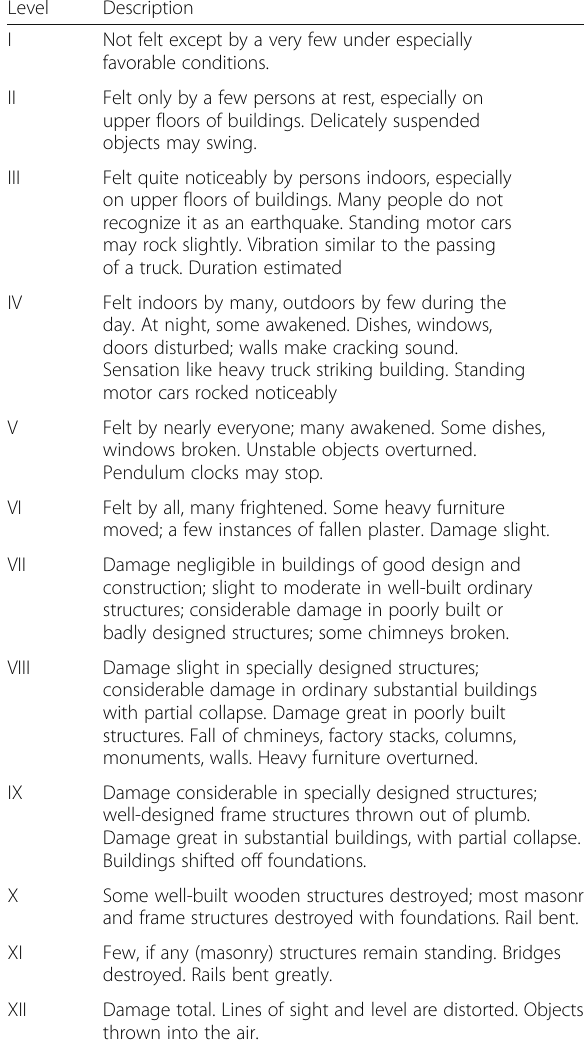
Table 1 Modified Mercalli Intensity Scale (Adapted from